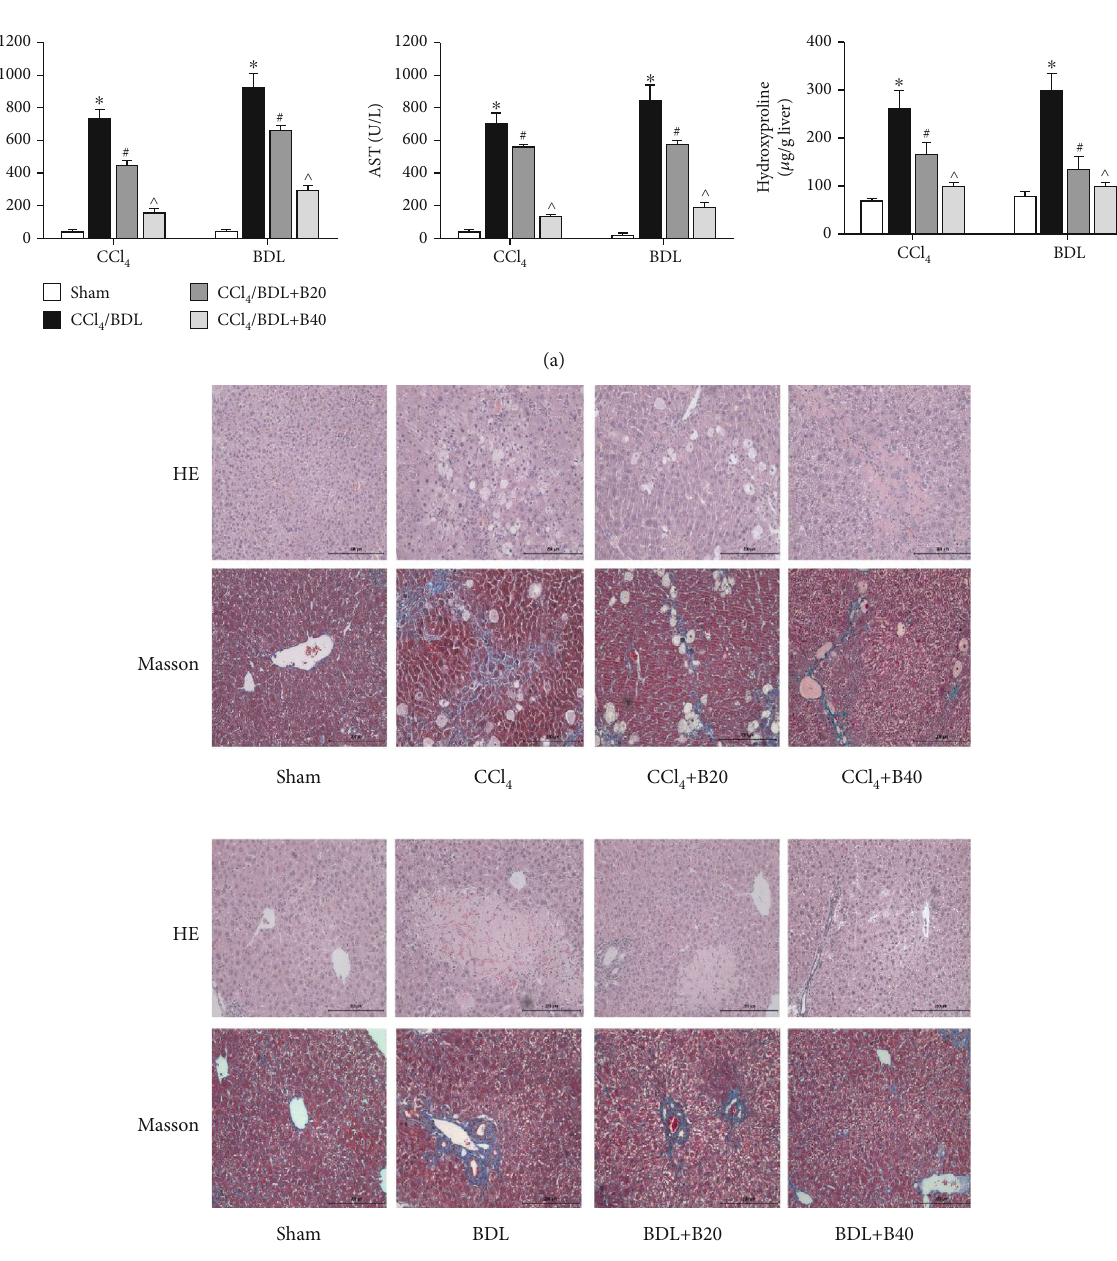
Figure 1: Bergenin signi fi cantly decreases liver fi brosis. (a) Levels of serum ALT and AST expressed as the mean ± SD ( n = 8 ). (b) HE and Masson staining of liver sections (original magnification = 200x